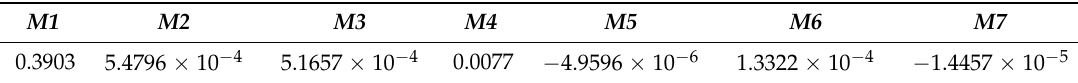
Table 3. Incomplete light spot invariant moments.